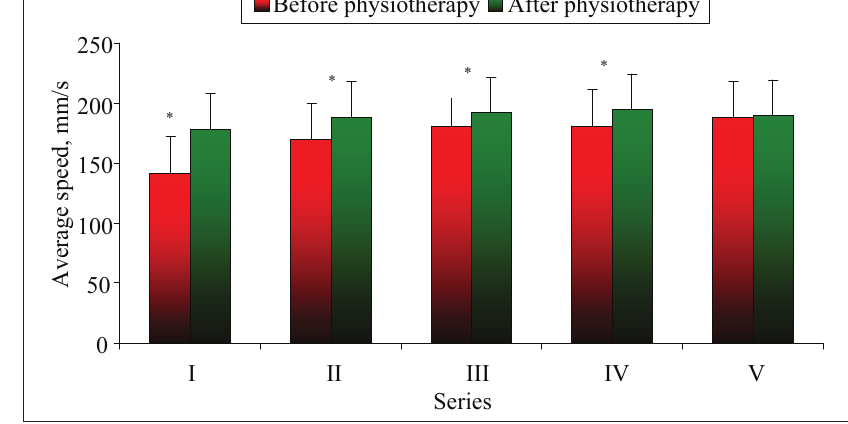
Figure 3. Maximal speed (mm/s) averages in patients with Parkinson’s disease performing a task of 5 sets of 20 repetitions before and after physiotherapy. Vmax -simple task, Vmax-JT -complicated